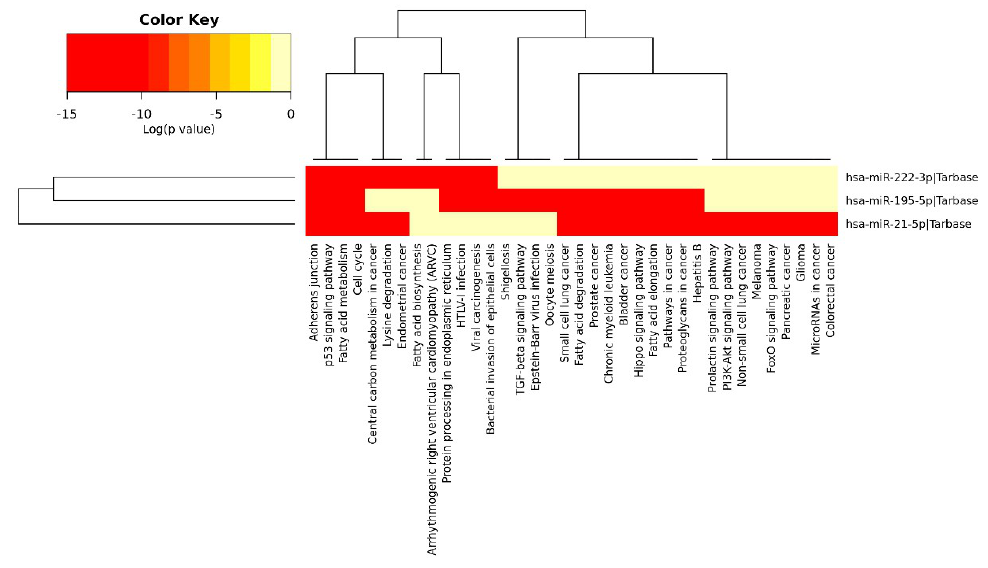
Figure 6. A heatmap showing the pathways altered by miR-222, miR-195 and miR-21a. The heatmap was generated with the DIANA miRPATH software, based on experimentally-validated miRNA interactions derived from the DIANA-TarBase. Axes on the attached dendrograms depict hierarchical clustering results for miRs and their pathways, respectively.